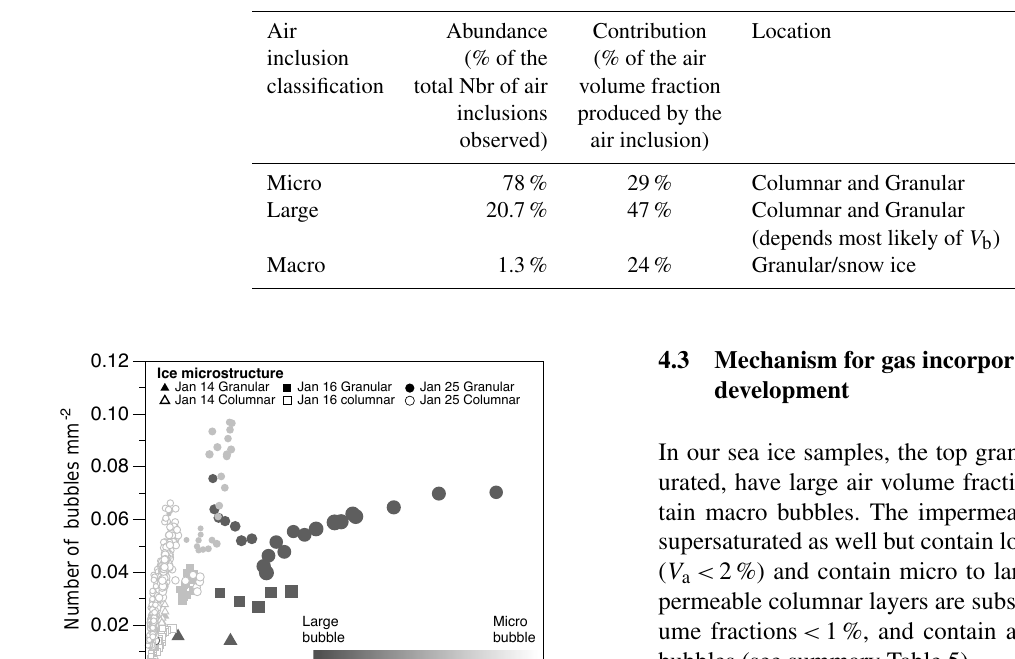
Table 4. Classification and properties of the air inclusions. The “abundance” is the proportion of micro, large, and macro bubbles on the total number of air inclusions observed (100% is the total number of inclusions in the three data sets (14 Jan + 16 Jan + 25 Jan)). The “contribution” is the percentile of the porosity produced by the micro, large and macro inclusions (100% is the total of air volume fraction observed in the three data sets (14 Jan + 16 Jan + 25 Jan)).